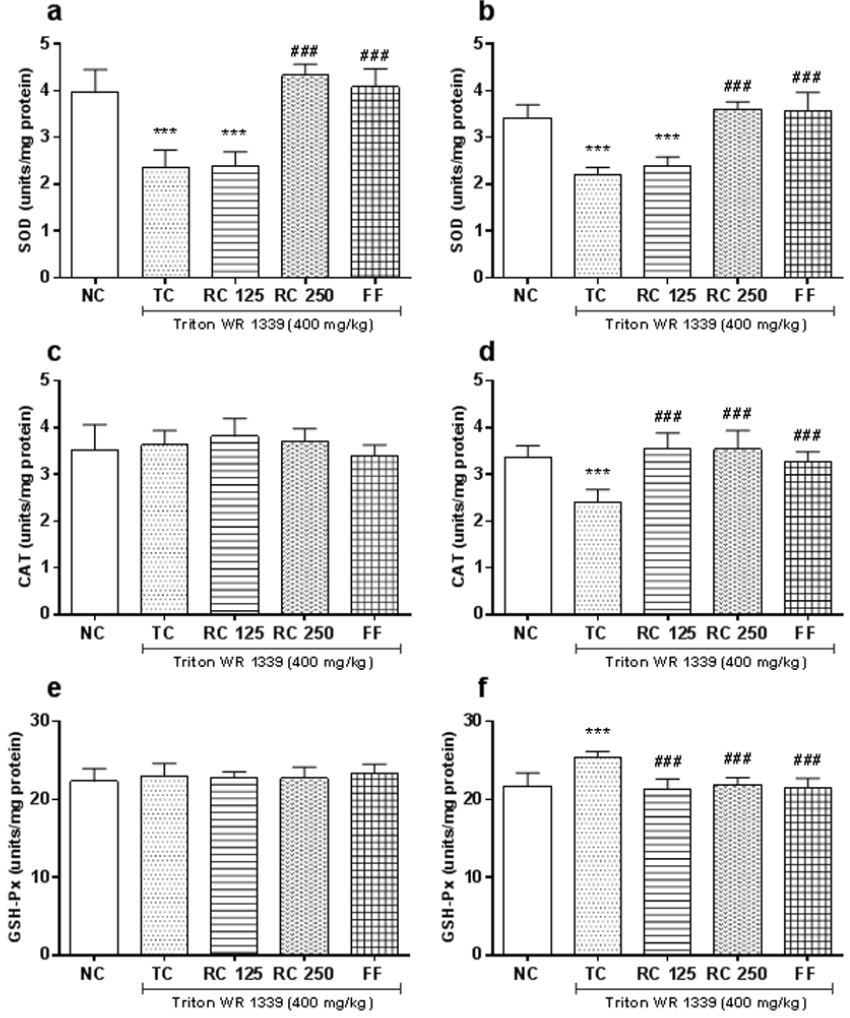
Figure 4. Effects of red cabbage aqueous extract (RC) and fenofibrate (FF) treatments on antioxidant enzymes activities in cerebral cortex (left, panels a, c and e) and hippocampus (right, panels b, d and f) of Triton WR-1339-induced hyperlipidemia in rats. Bars represent means± S.D. (n=5–6). *** p <0.001 vs normal control (NC) and ### p <0.001 vs Triton control (TC), according to one-way ANOVA followed by Tukey’s test. SOD= superoxide dismutase; CAT= catalase; GSH-Px= glutathione